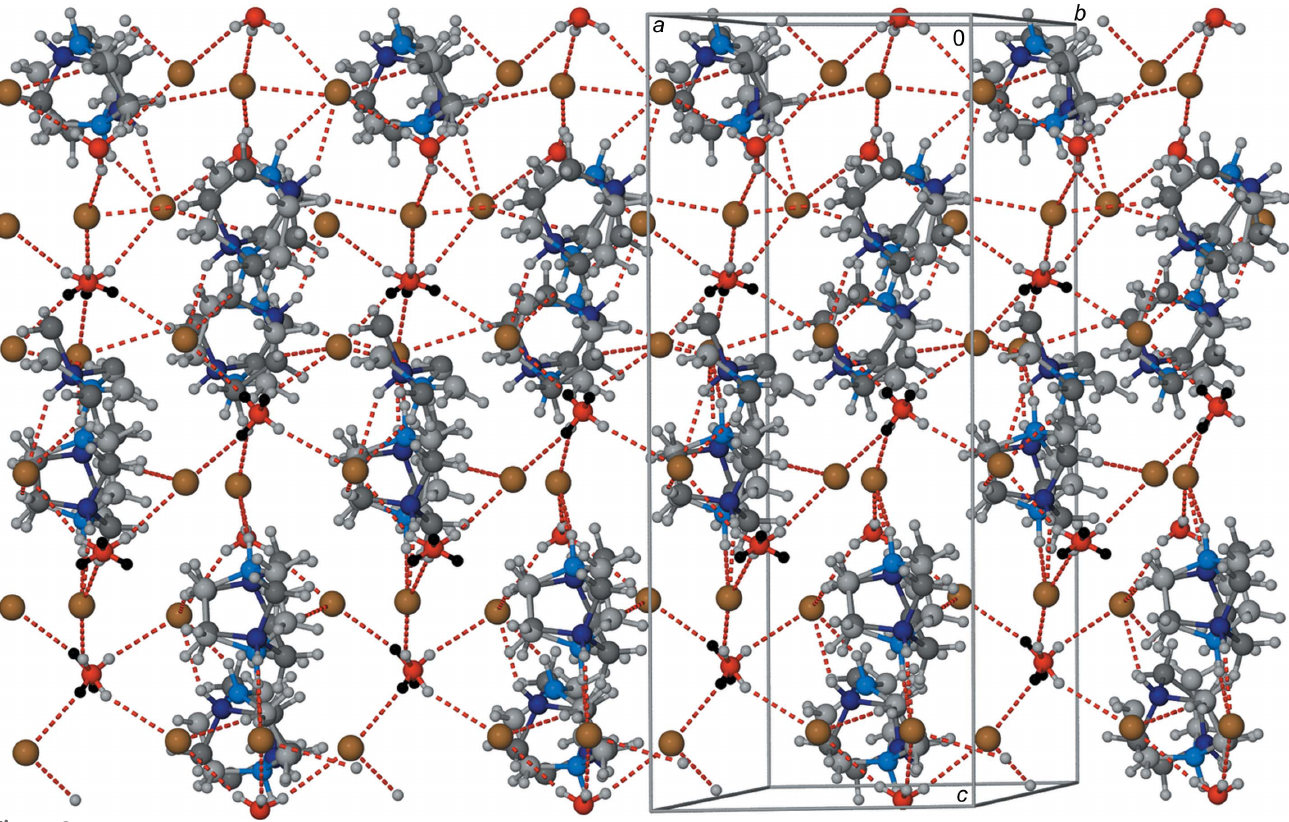
Figure 2 Autostereographic view (Katrusiak, 2001) of the structure of (cid:2) -[dabcoH 2 ] 2+ H 3 O + Br (cid:2) 3 . Hydrogen bonds are indicated by cyan lines. Colour code: brown Br, red O; for disordered cations their different positions are distinguished by two colours: light and dark blue N, light and dark grey C; light-grey and black